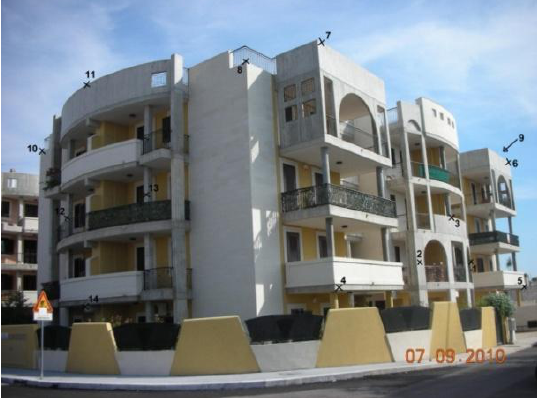
Figure 7. Control vertices located on the North and West sides